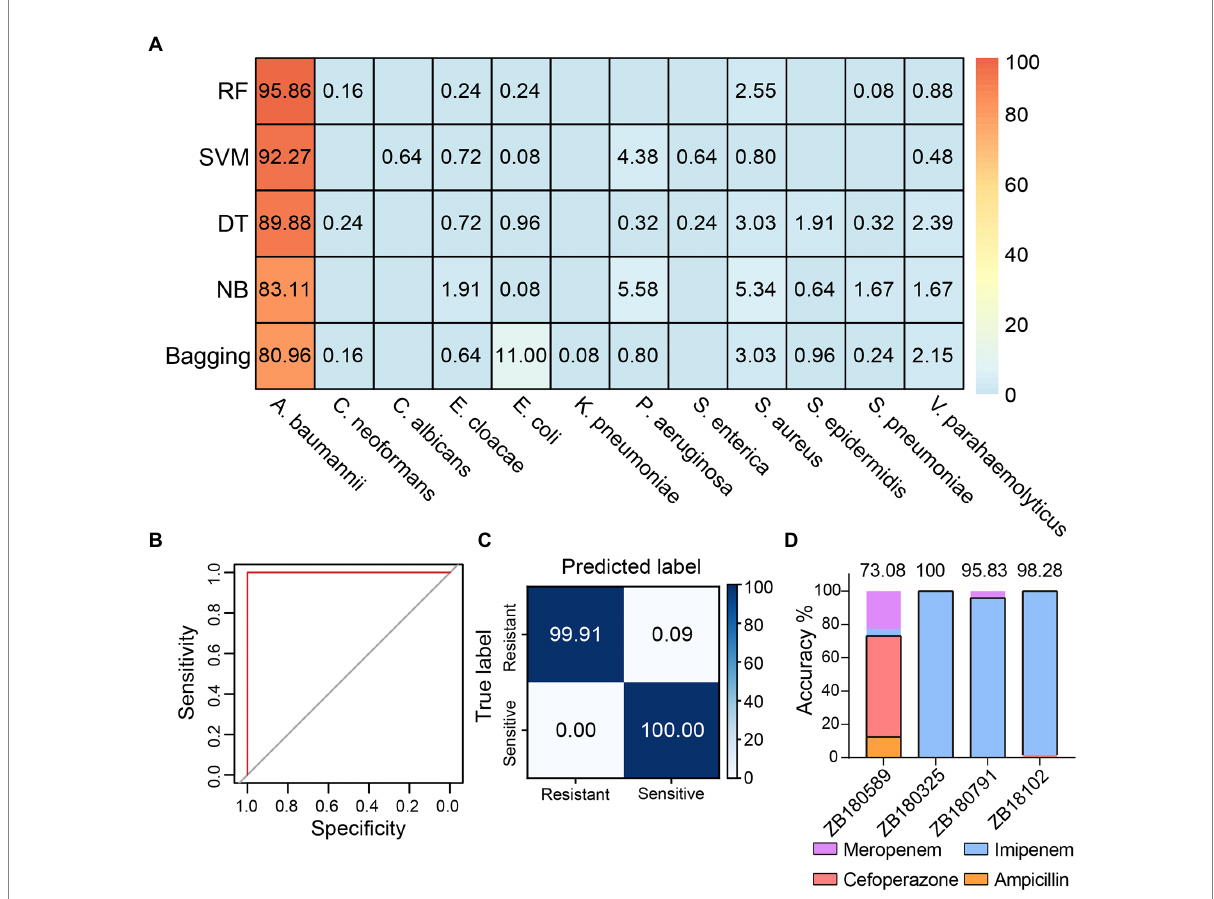
FIGURE 3 Detection of multidrug-resistant Acinetobacter baumannii . (A) The identification accuracies achieved by different models using the 1,255 Raman spectra acquired from different A. baumannii strains. RF: random forest, SVM: support vector machine, DT: decision tree, NB: naive Bayes. (B) The receiver operating characteristic (ROC) curve of discriminating antibiotic-resistant bacteria by RF model based on the Raman spectra. Both the average AUC values of resistant and sensitive bacteria are 1. (C) The confusion matrix shows that the RF antibiotic susceptibility detection model distinguishes between antibiotic-resistant and -sensitive A. baumannii strains with 99.92 ± 0.06% accuracy. (D) The antibiotic predictions for treatment of A. baumannii by the RF model. The black boxes indicate the proportion correctly